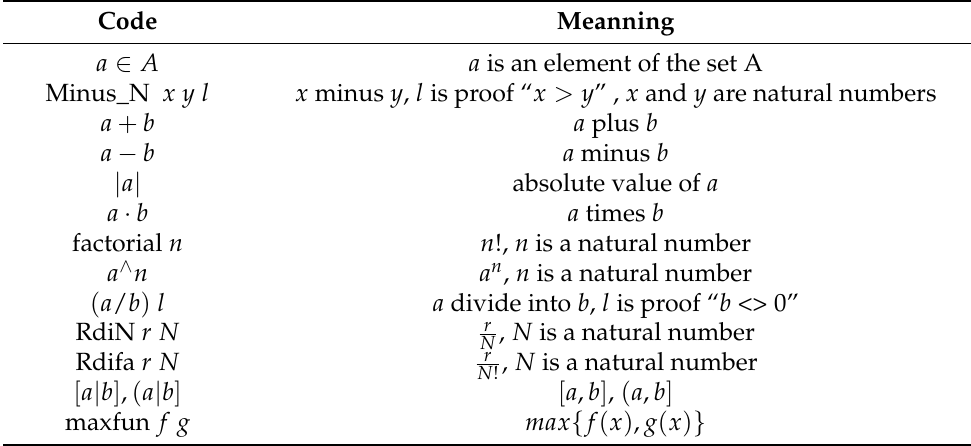
Table 1. The meaning of the code in real number theory